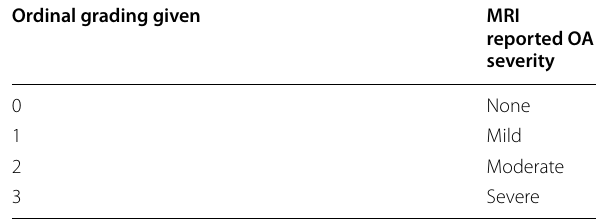
Table 3 Ordinal MRI grading for OA severity Ordinal grading